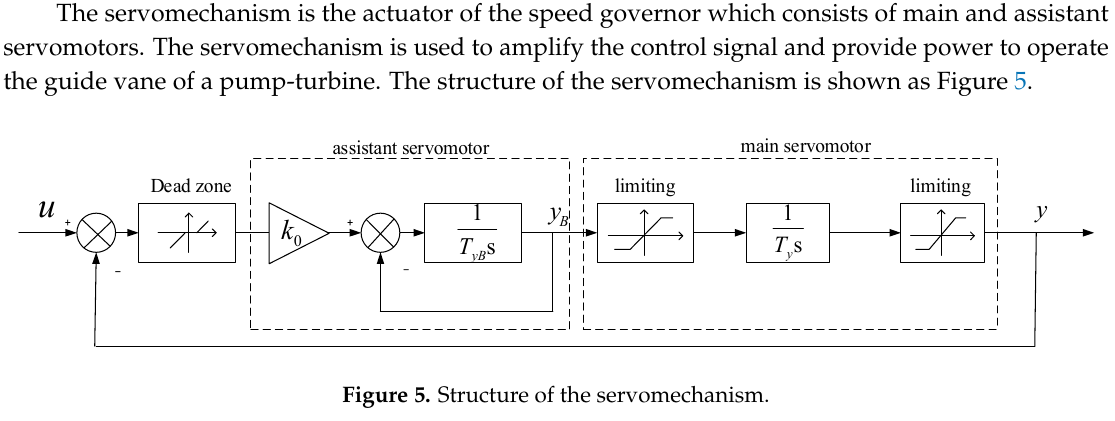
Figure 5. Structure of the servomechanism.